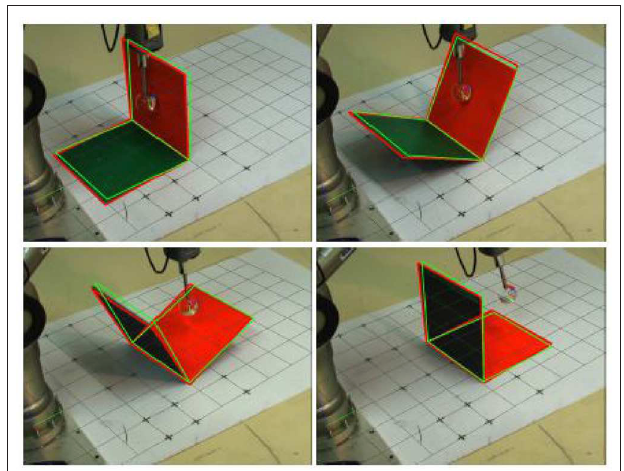
FIGURE 8 | The example shows the interaction between a 5-axis Katana robotic manipulator and an L-shape object, called polyflap ( Sloman, 2006). A set of contact experts are learned as probability densities for encoding geometric relations between parts of objects under a push operation. This approach allows these experts to learn from demonstration physical properties, such as non-penetration between an object and a table top, without explicitly representing physics knowledge in the model. The green wire frame denotes the prediction whilst the red wire frame denotes the visual tracking. Courtesy of Kopicki et al.